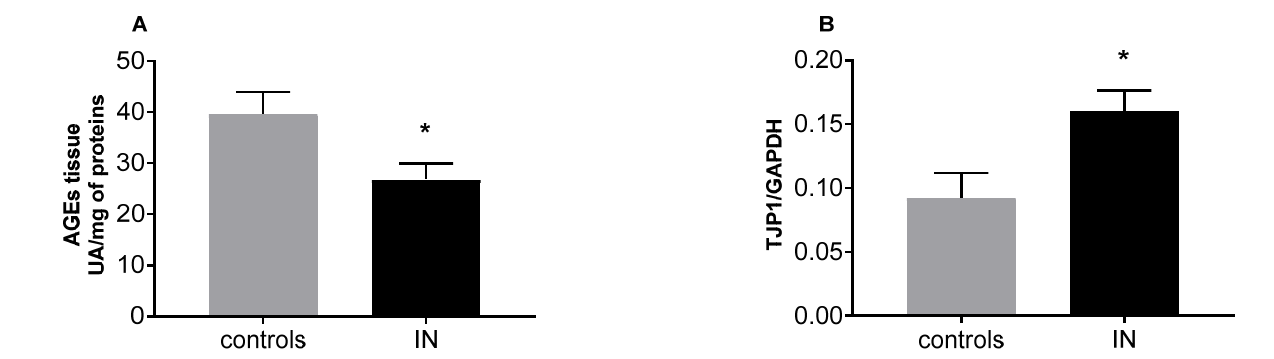
Figure 1. Mean days of postoperative (POD) fluid ( A ) and solid oral diet resumption ( B ) and time of first bowel movement, considering both the first POD flatus passage ( C ) and stool passage ( D ) in controls and in IN patients. Data are expressed as means ± SEM * p < 0.05 by unpaired t test.